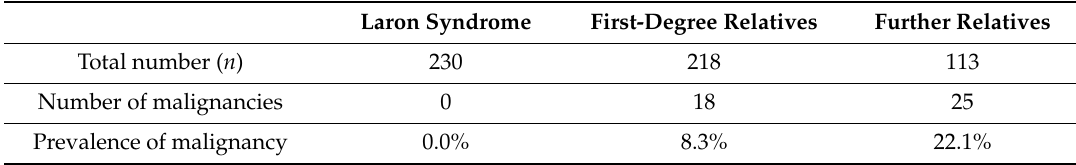
Table 2. Epidemiological analysis of cancer prevalence in LS